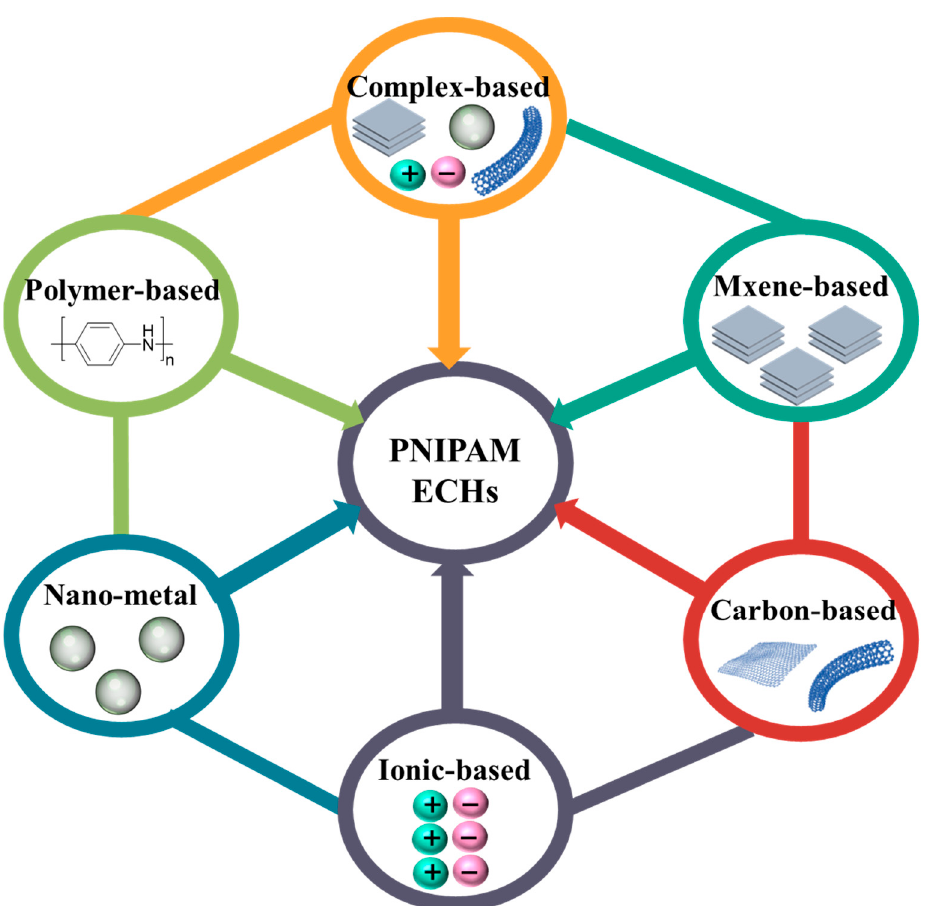
Figure 2. Scheme of 6 categories of PNIPAM-ECHs based on their conductive components.